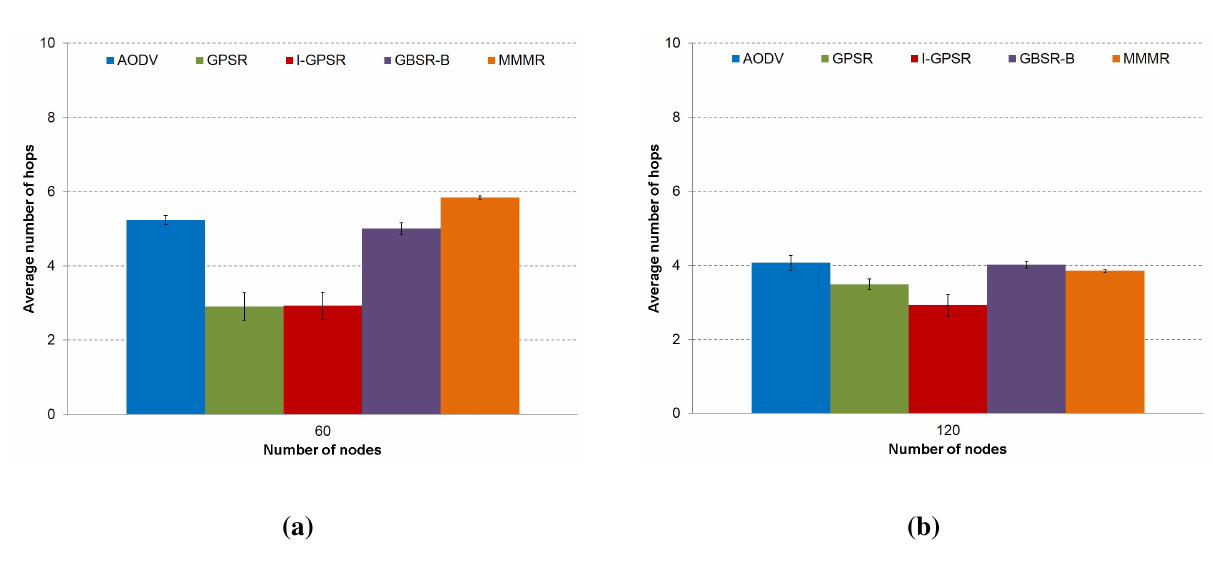
Figure 6. The average number of hops to the destination in ( a ) a low density scenario (60 nodes) and ( b ) a medium density scenario (120 nodes) are presented, comparing